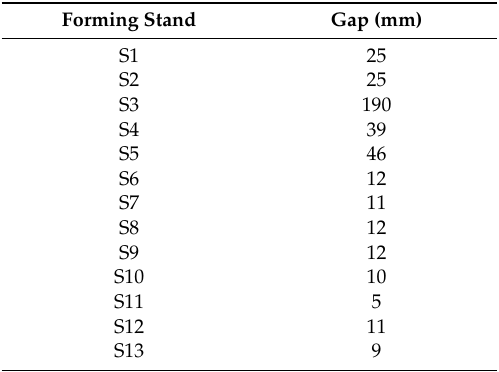
Table 1. Manufacturing program of the rolling mill.